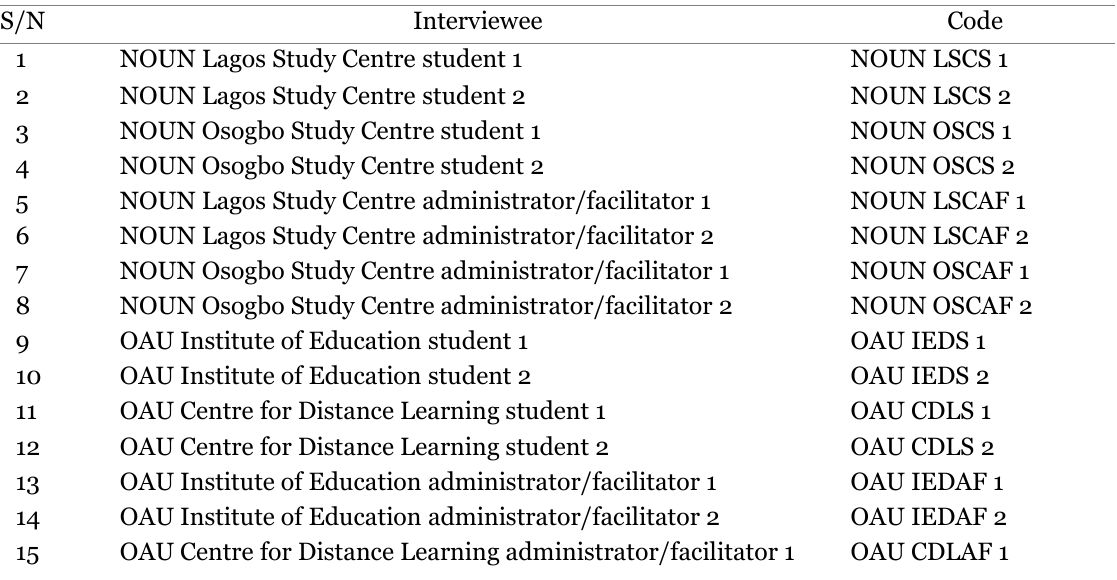
Codes for Interviews of Participants in the